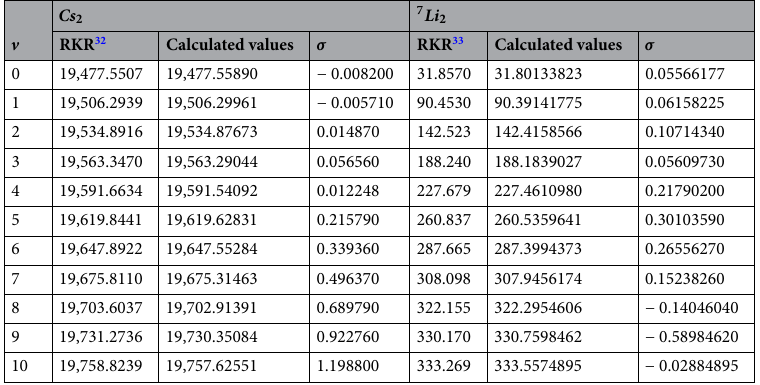
Table 3. Comparison of RKR data ( cm − 1 ) with calculated energies of Cs